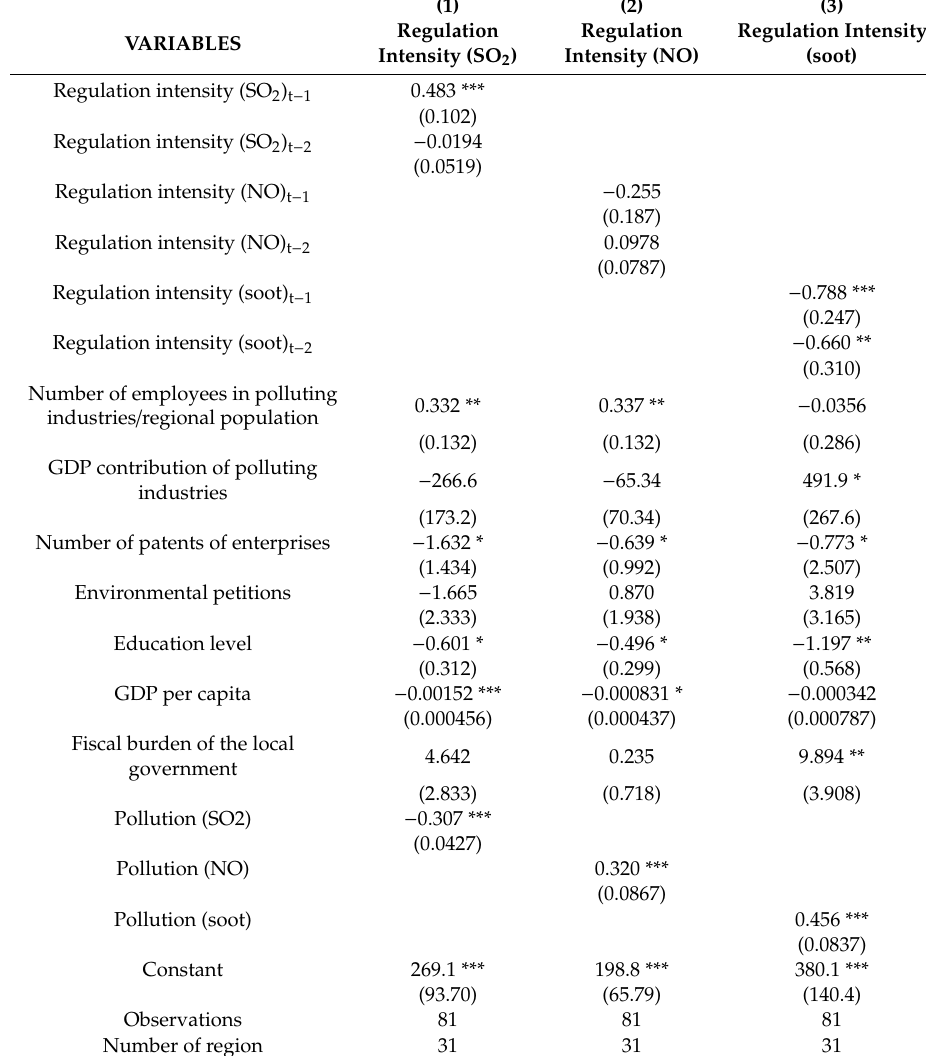
Table 5. The regression results by the GMM 2SLS method